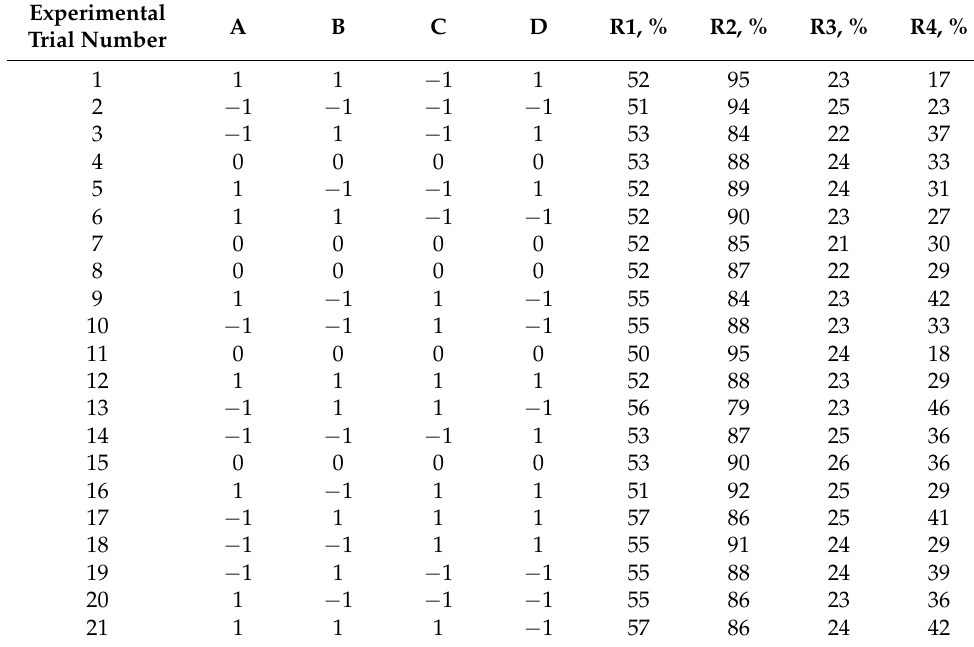
Table 3. Full factorial design matrix and responses. “1” corresponds to a high factor level; “ − 1” refers to a low factor level; and “0” refers to a center point. Experimental Trial